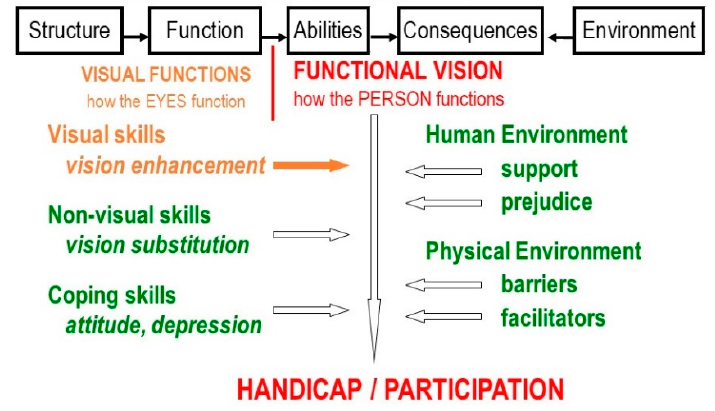
Figure 4. Factors in comprehensive vision rehabilitation.